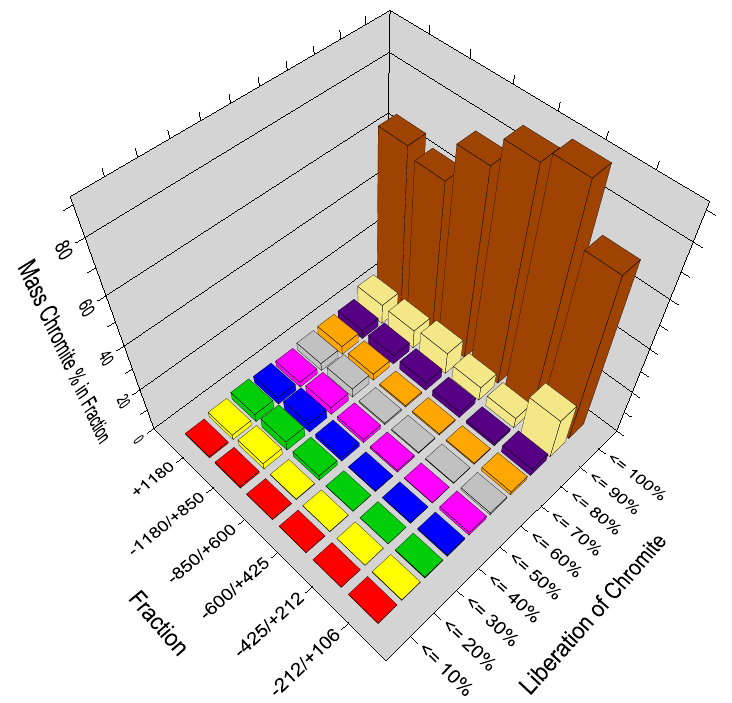
Figure 6. Plot of the mass percentages of chromite relative to the level of liberation of chrome-rich spinel grains by size.